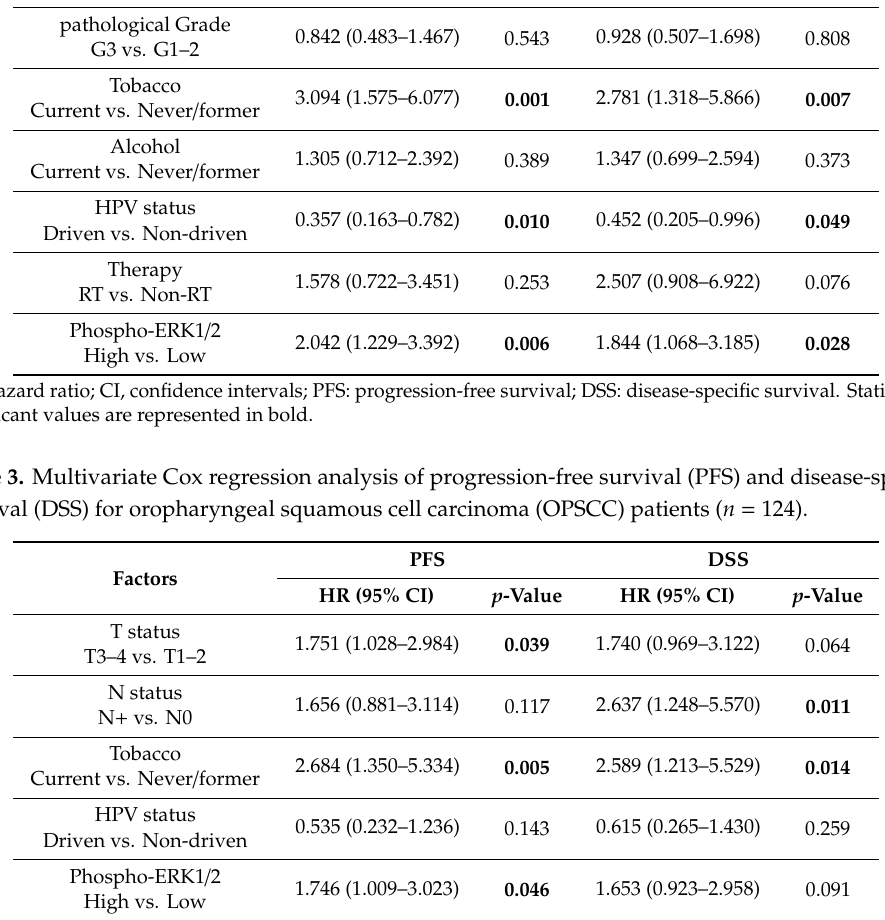
HR, hazard ratio; CI, confidence intervals; Statistically significant values are represented in